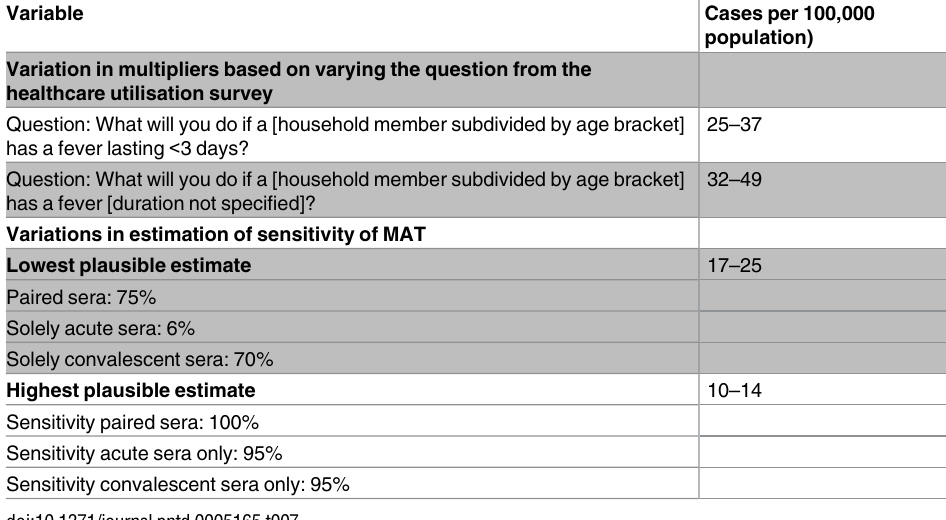
Table 7. Sensitivity analysis of leptospirosis incidence, Moshi Rural and Moshi Urban Districts, Tan- zania, 2012–14. Variable Cases per 100,000